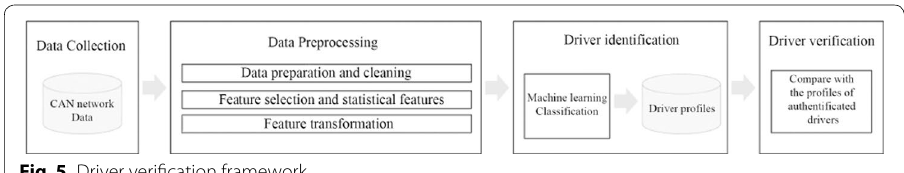
Fig. 5 Driver verification